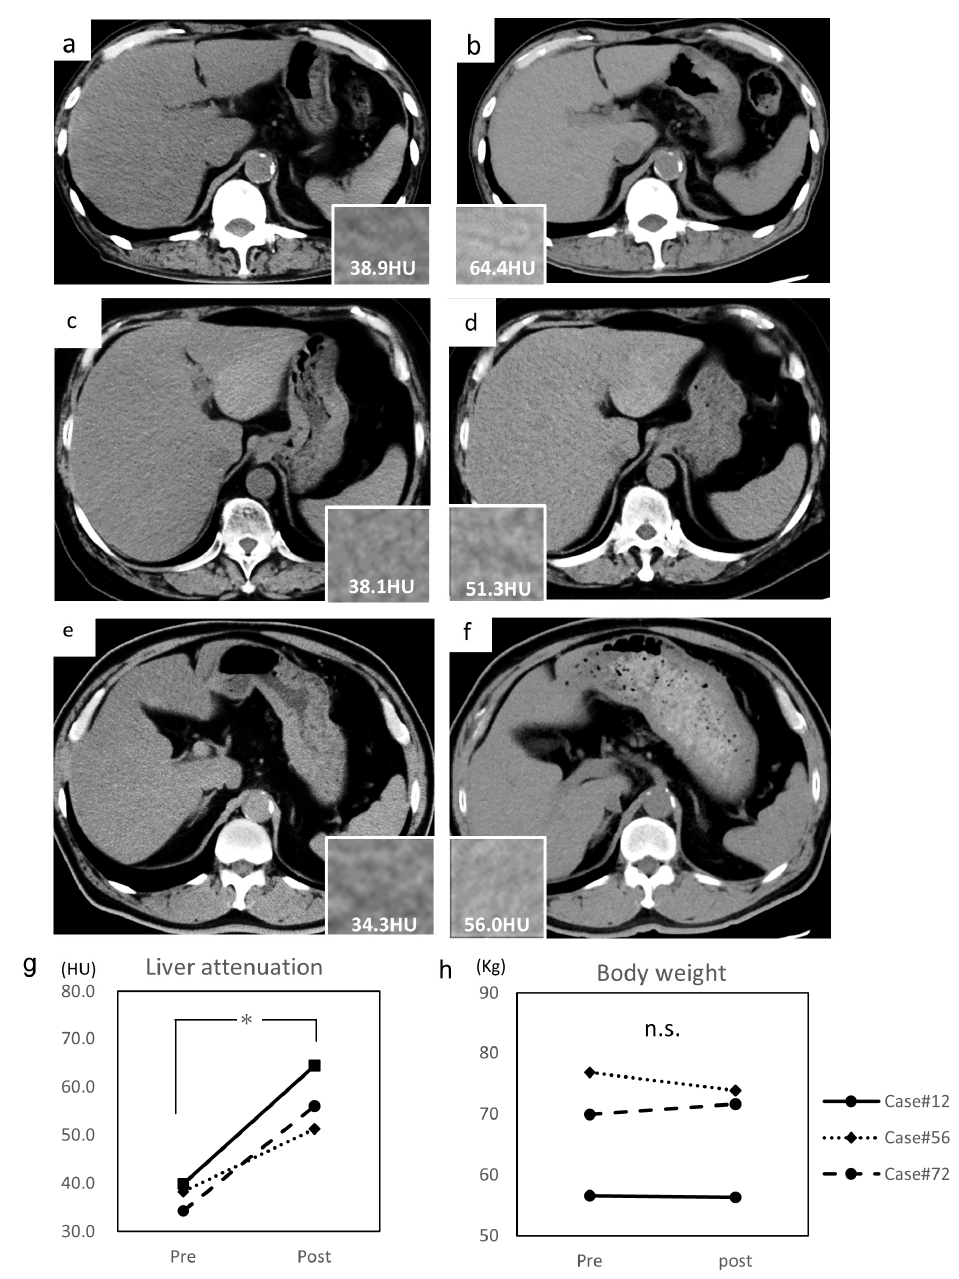
Figure 3. Alteration of liver attenuation assessed by CT imaging. ( a ) Pre-treatment abdominal CT of Case #12, ( b ) post-treatment abdominal CT of Case #12, ( c ) pre-treatment abdominal CT of Case #56, ( d ) post-treatment abdominal CT of Case #56, ( e ) pre-treatment abdominal CT of Case #72, and ( f ) post-treatment abdominal CT of Case #72. ( g ) Alteration of liver attenuation assessed by CT imaging before and after treatment. Liver attenuations are indicated in each column. ( h ) Alteration of body weight before and after treatment. Hounsfield unit, HU. Data are expressed as mean with standard error of the mean (SEM). n.s. not significant, * p < 0.05.